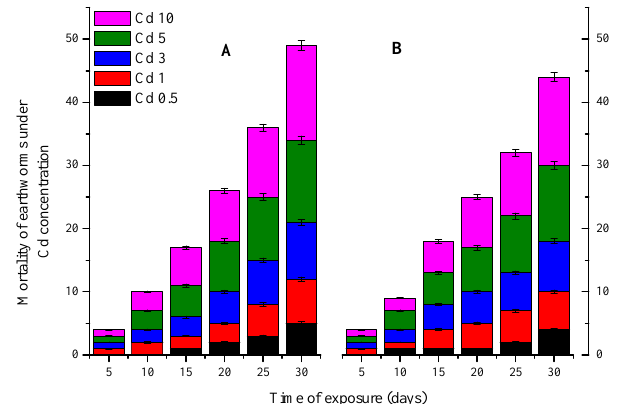
Figure 1. Mortality of E fetida ( A ) and A. caliginosa ( B ) under Cd stress at different concentration (0.5, 1, 3, 5 and 10 mg kg − 1